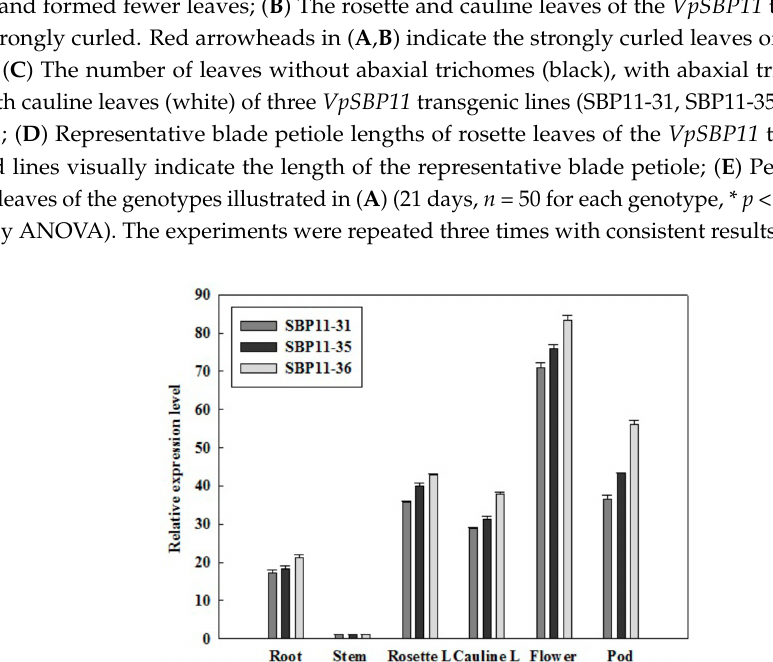
Figure 6. Spatial expression pattern of VpSBP11 . The relative expression levels of VpSBP11 were measured in different organs of WT and three transgenic lines (SBP11-31, SBP11-35, and SBP11-36): Root, Stem, Rosette Leaf (Rosette L), Cauline Leaf (Cauline L), Flower, and Pod. Expression in the stem was the lowest and was selected as the base value of comparison. AtActin1 was used as an internal control for qRT-PCR. Mean values and SDs were obtained from three biological experiments with consistent results.